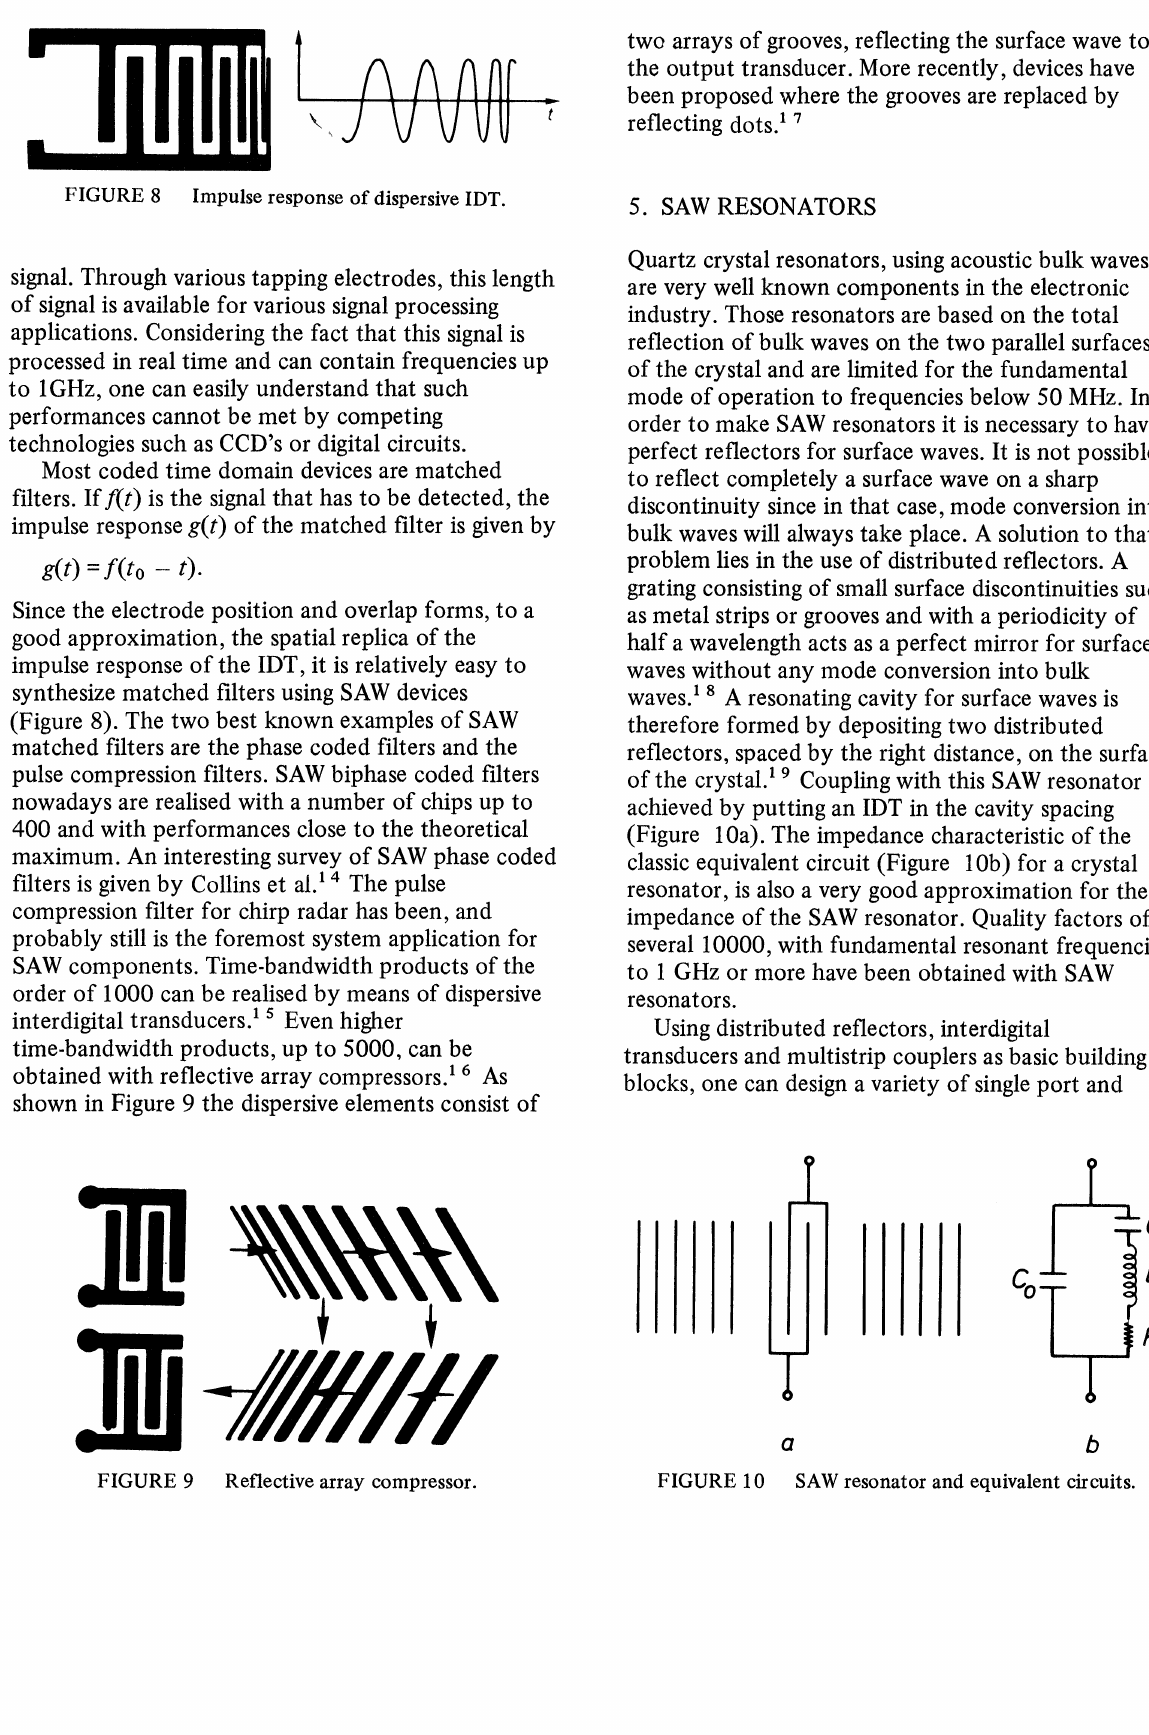
two arrays of grooves, reflecting the surface wave to the output transducer. More recently, devices have been proposed where the grooves are replaced by reflecting dots. 7